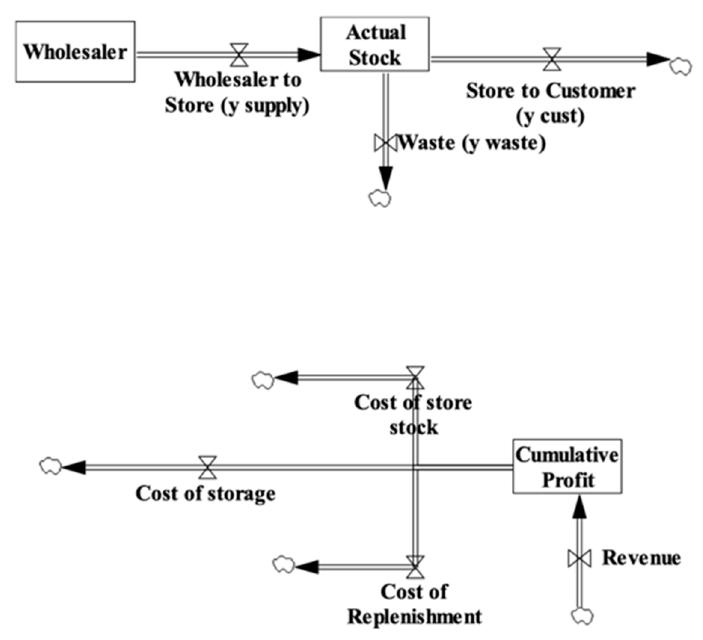
Figure 1. Stocks and flows of food and money within the SFO Visual